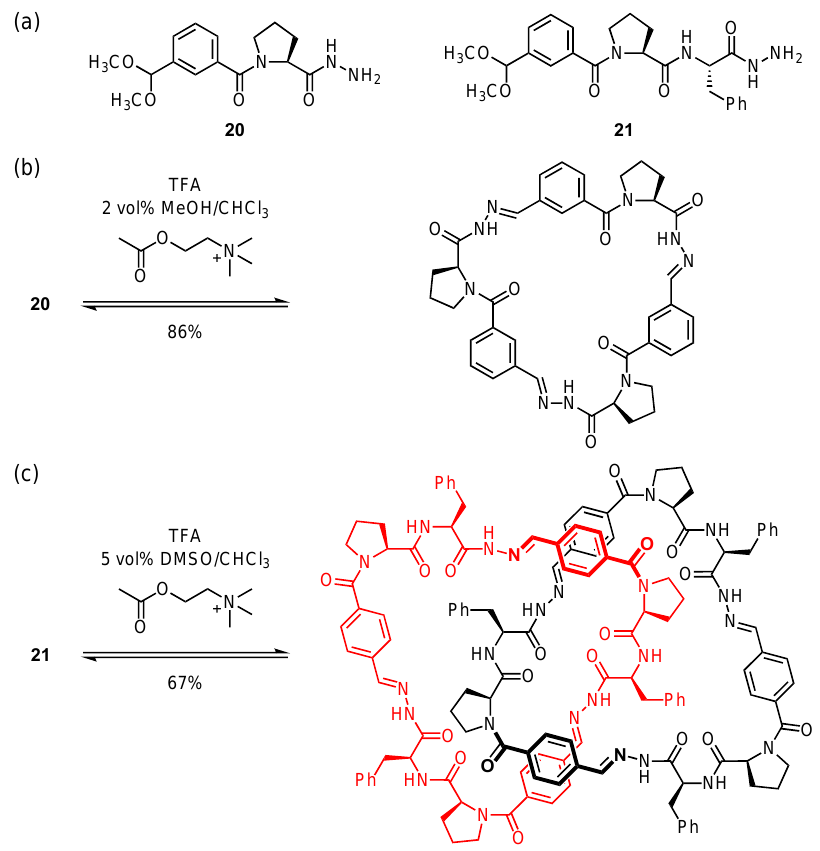
Figure 11. Structures of building blocks 20 and 21 ( a ), acetylcholine-templated synthesis of a macrocyclic trimer from 20 ( b ), and of a [2]catenane comprising two macrocyclic trimers from 21 ( c ).